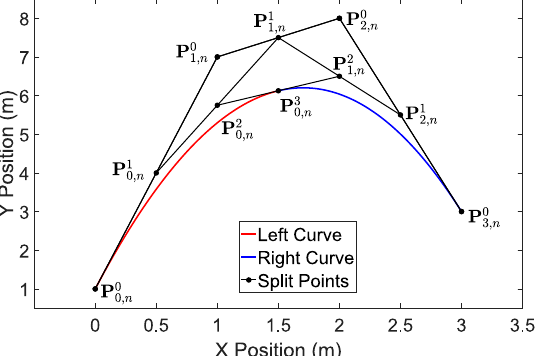
Figure A2. Geometric example of the de Casteljau algorithm splitting a 2D Bernstein polynomial at t div = 0.5. The original curve is defined by the Bernstein coefficients { P 0 curve is shown in red, the right hand curve is shown in blue, and the superscript corresponds to the current iteration of the